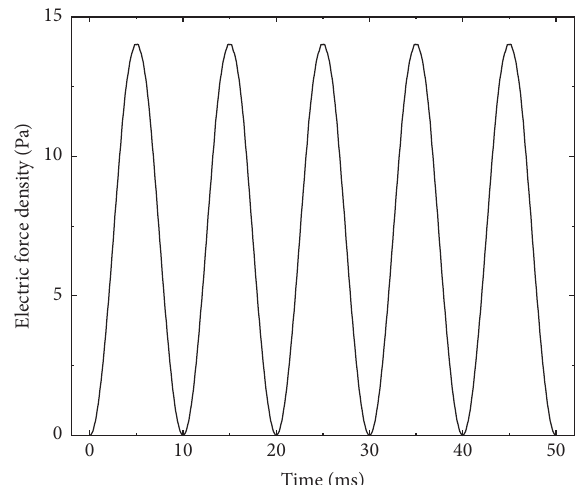
Figure 7: The electric force density in the time domain.